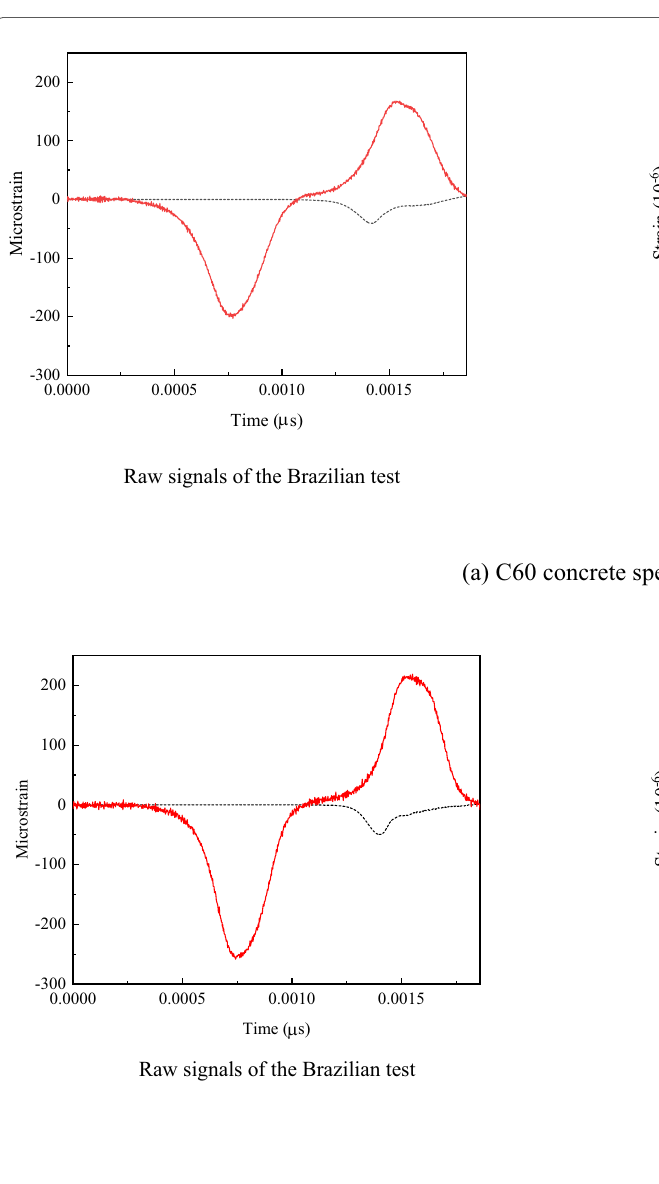
Fig. 2 Impulse signals acquired in dynamic splitting